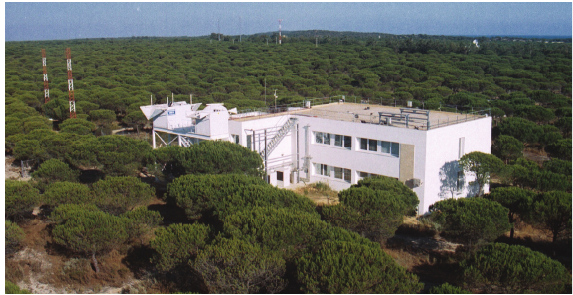
Figure 2: The building of ESAt with domes of BOOTES-1A and BOOTES-1B